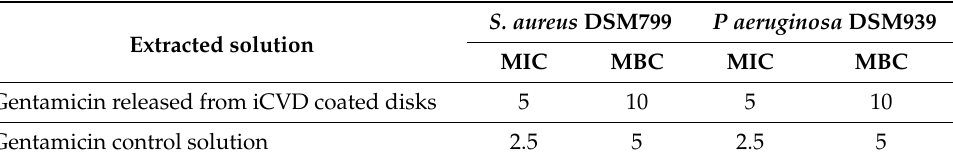
Table 3. Minimal inhibitory concentration (MIC) and minimal bactericidal concentration (MBC) values, in µ g / mL, of active gentamicin released from disks producing MIC in comparison with that produced by free gentamicin in water. iCVD layer prepared with an EGDMA volume fraction of 60%. S. aureus DSM799 P aeruginosa DSM939 Extracted solution MIC MBC MIC MBC Gentamicin released from iCVD coated